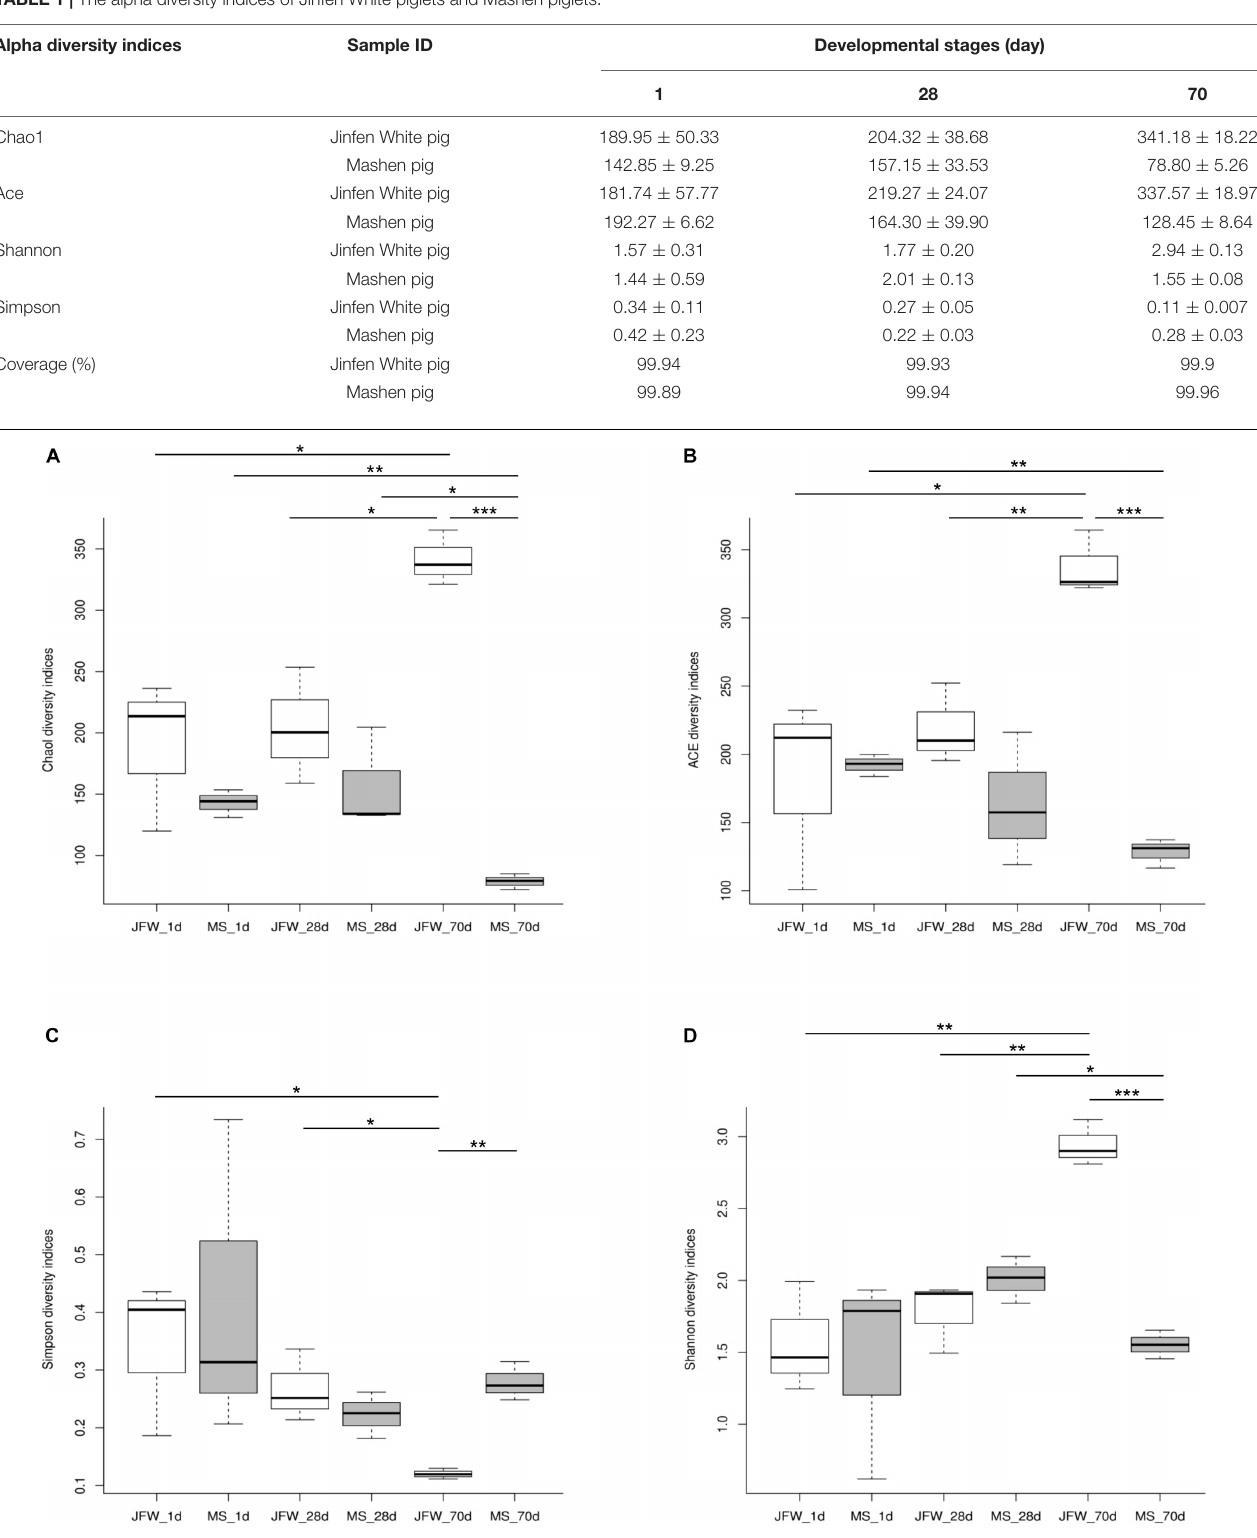
FIGURE 3 | The ileum microbiota α diversity of Jinfen White and Mashen piglets. (A) Chao1 indices, (B) ACE indices, (C) Simpson indices, and (D) Shannon indices. * P < 0.05, ** P < 0.01, and *** P < 0.001 indicate significant difference among different time points.